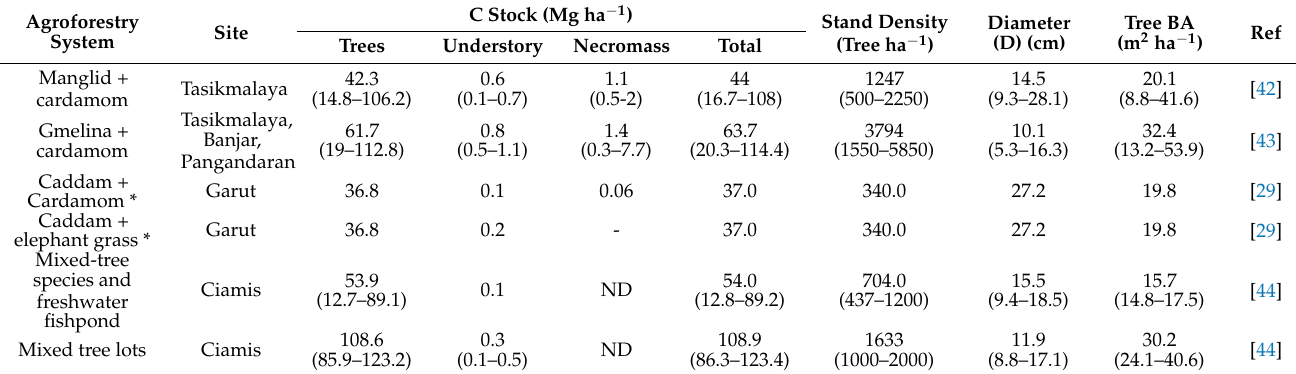
Table 3. C sequestration capacity of various agroforestry systems in study sites in West Java province. Agroforestry System